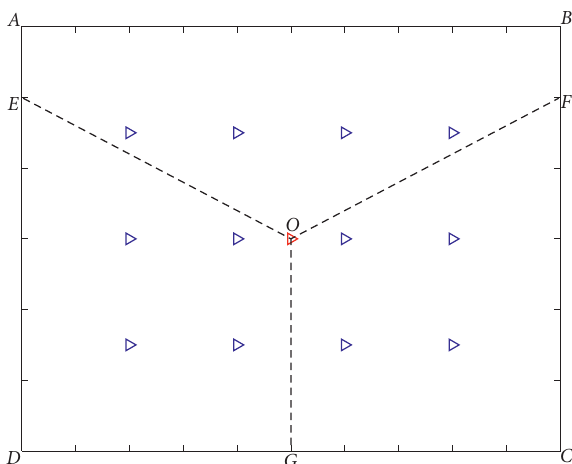
Figure 2: Dividing the area under operation from the center among 3 gatherers when the targets are uniformly distributed over the space. Each coordinate corresponds to a grid; hence, each target occupies one grid